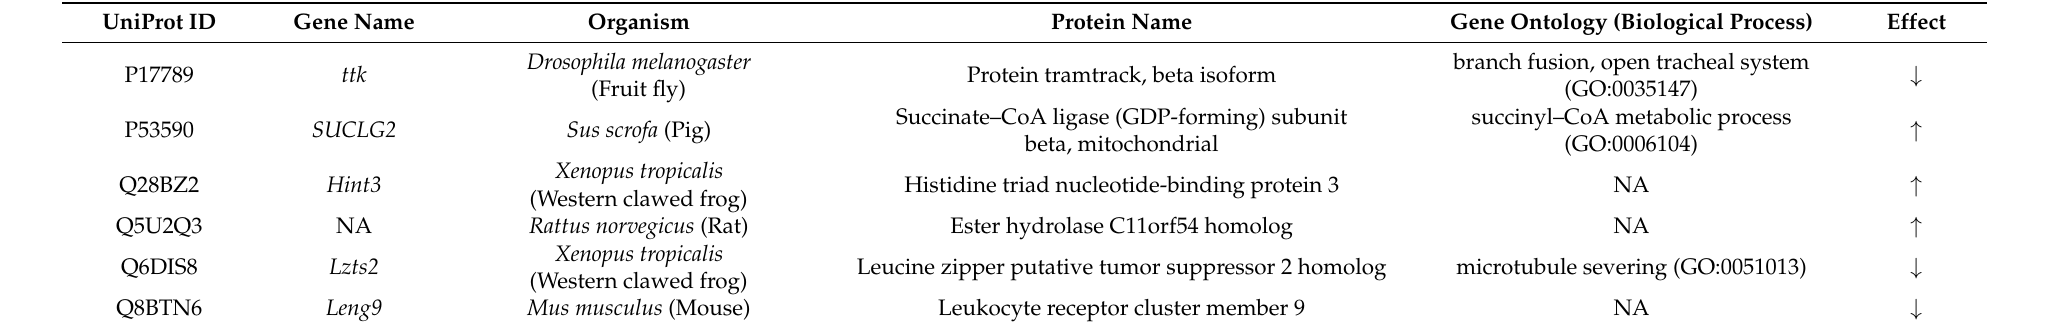
Table 3. List of six transcripts and their annotations (based on BLASTp) that were commonly identified in the individual datasets and the Fisher method. Direction of the arrow represents whether the representative transcript is downregulated ( ↓ ) or upregulated ( ↑